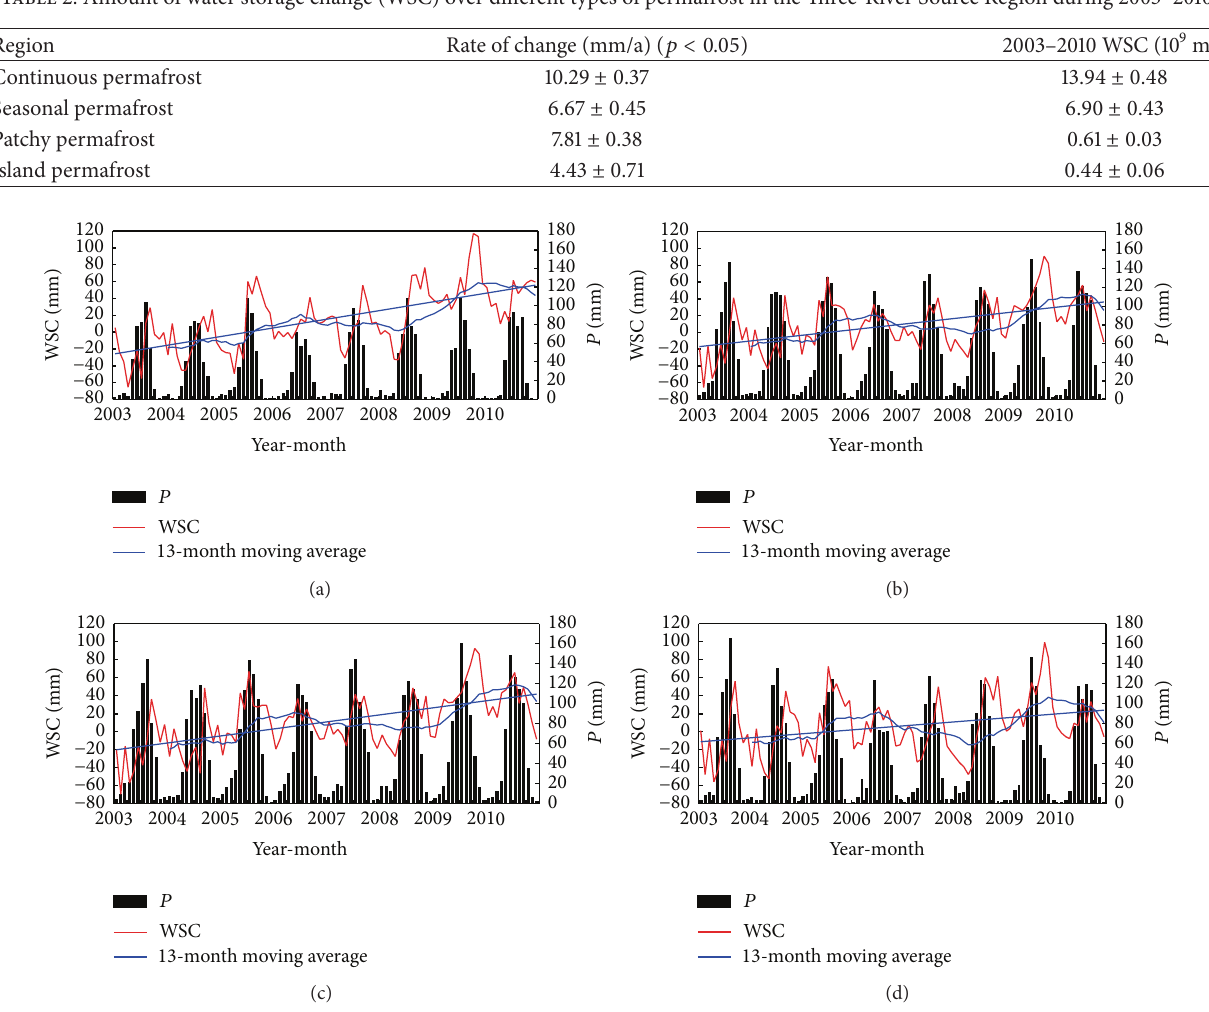
Figure 6: Time series of water storage change (WSC) and precipitation ( 𝑃 ) over different types of permafrost during 2003–2010: (a) continuous permafrost, (b) seasonal permafrost, (c) patchy permafrost, and (d) island